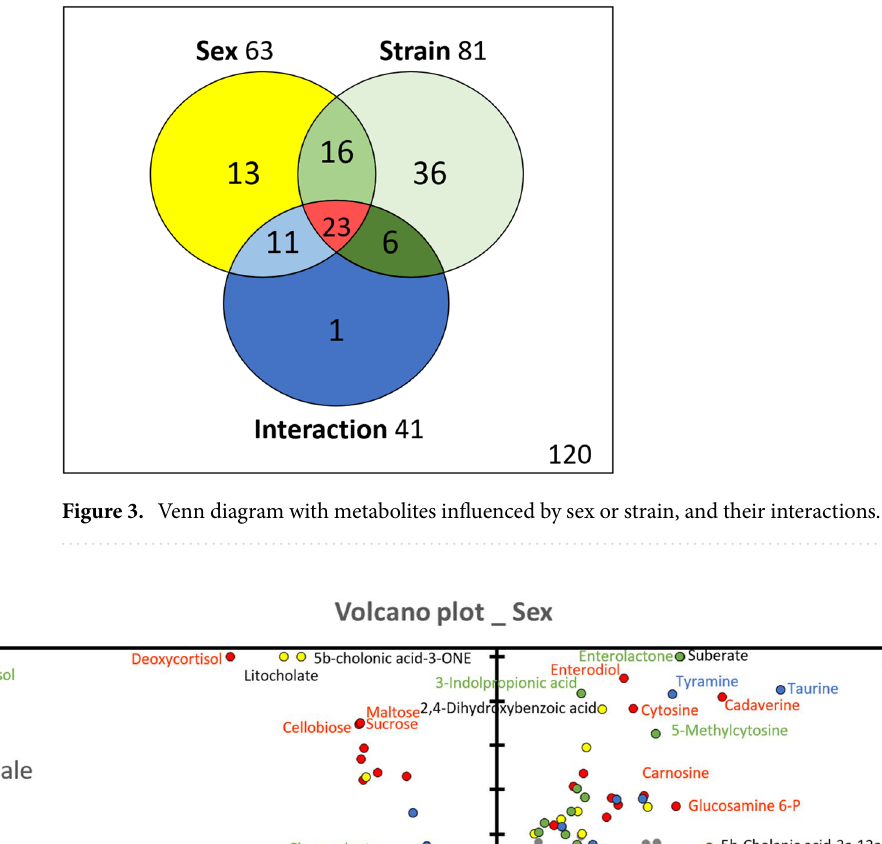
scale. Blue points (Sex*Interaction) below mark aminoacid (Taurine and tyramine). In order to access enrichment statistics and to analyze differential expression rates, we submitted these results